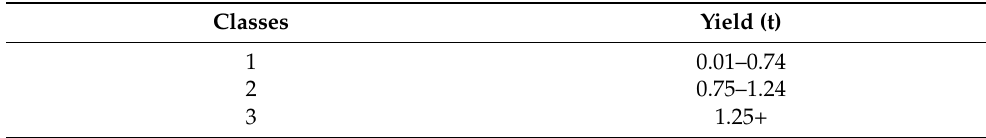
Table 2. The classification trees split the data into these